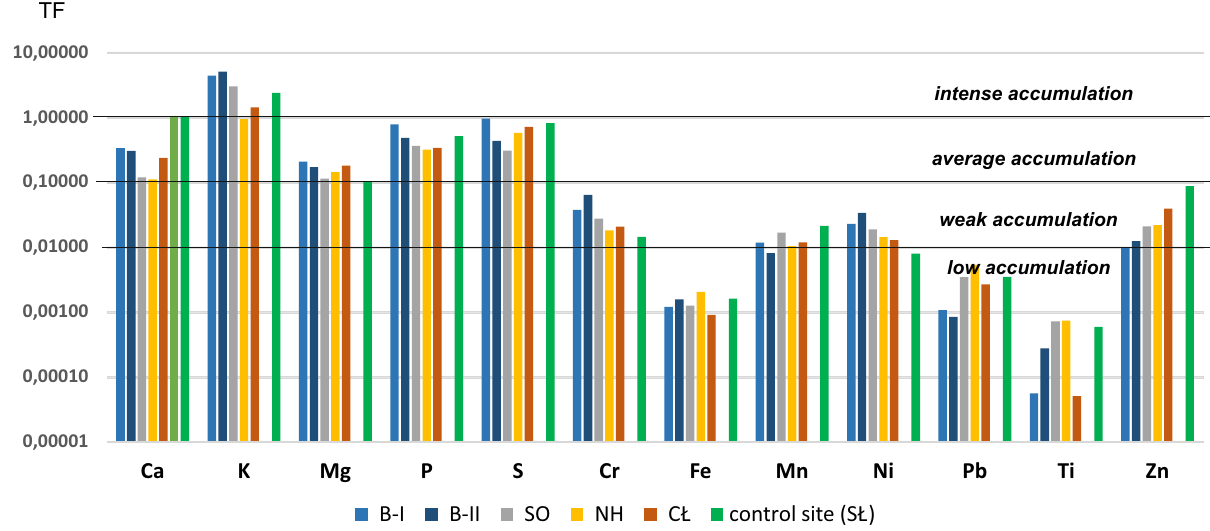
Figure 3. Transfer factor of macro- (Ca, K, Mg, P and S) and microelements (Cr, Fe, Mn, Ni, Pb, Ti and Zn) in lettuce growing on soils from industry areas (B-I, B-II, SO, NH and CŁ) and control site